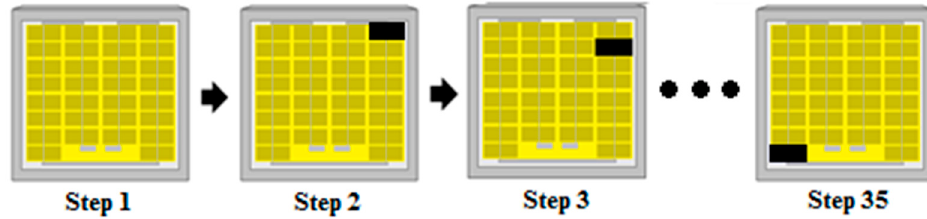
7 of 14 Figure 8. The equivalent circuit of the solar module: ( a ) Normal cell shaded condition; ( b ) Defective cell shaded condition. Figure 9 presents the I - V characteristics of normal cell shaded condition and Defective cell shaded condition to better understand the theory. V 0 is the reference voltage of load resistor without shadow. Since the shaded normal cell becomes p-n junction diodes with high shunt resistance, the voltage share of the resistor R is low ( V 1 ). Meanwhile, shunt resistance of the shaded defective cell is relatively low, so that the resistor R shares much higher voltage ( V 2 ). Accordingly, the current of the defect cells has a linear relationship with the reverse load voltage, the voltage share ratio between the defective cell and resistor R is generally stable. V 0 V 2 V 1 1/R Figure 9. I - V characteristics of normal cell shaded condition and Defective cell shaded condition. 3.3. Operating Procedure The detection is started with illuminating an entire module by the projector. Afterward, variable resistor R is adjusted to an appropriate value. Then the projector displays the animation as shown in Figure 10 on each module individually. The initial voltage value V 0 is measured when the module is